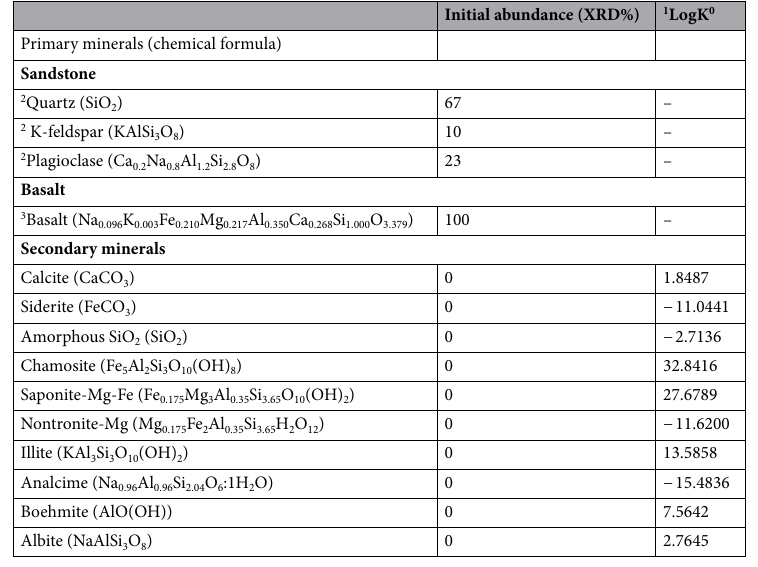
Table 1. Initial abundance of primary and secondary phases applied to the model. 1 All thermodynamic data comes from the carbfix.dat database 37 . 0 note standard state (temperature of 298 K and 1 bar pressure). 2 Initial abundance normalized for quartz, K-feldspar and plagioclase. 3 Basalt chemistry from 16